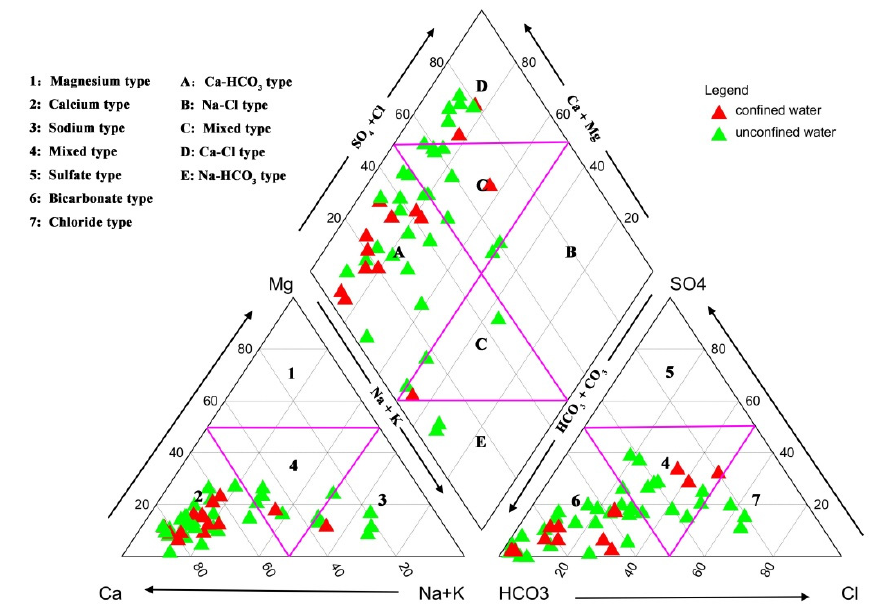
Figure 8. Piper diagram of 48 groundwater samples in the study area.